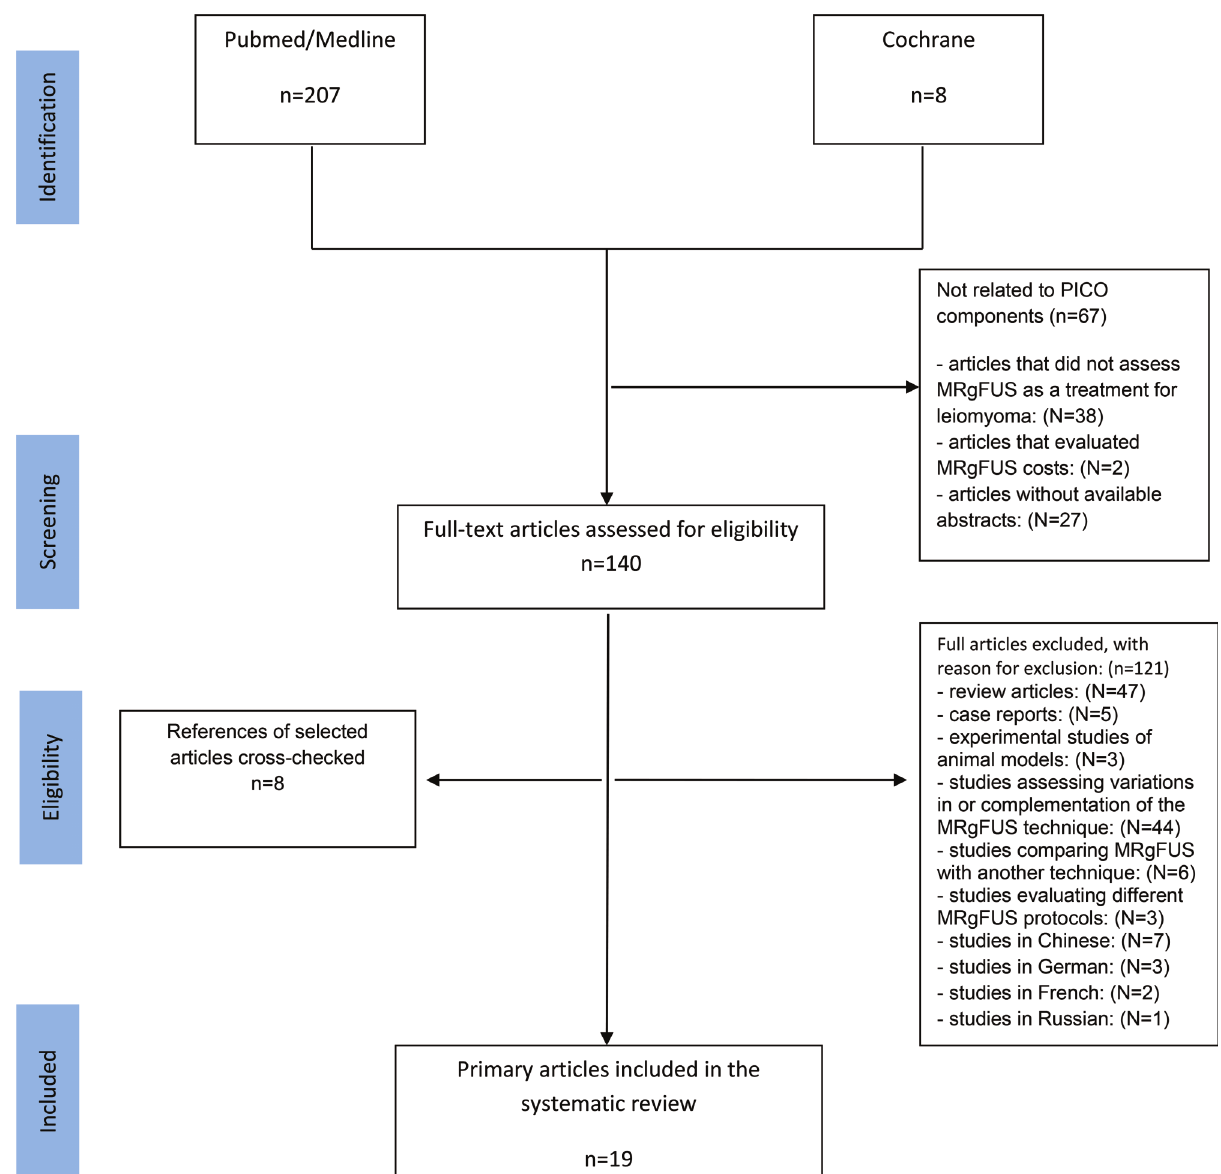
Figure 1 - Flowchart: Selection of studies included in the review. Table 1 - Studies assessing the decrease in fibroid volume and the necrosis volume immediately after treatment in symptomatic women. Author and Year of